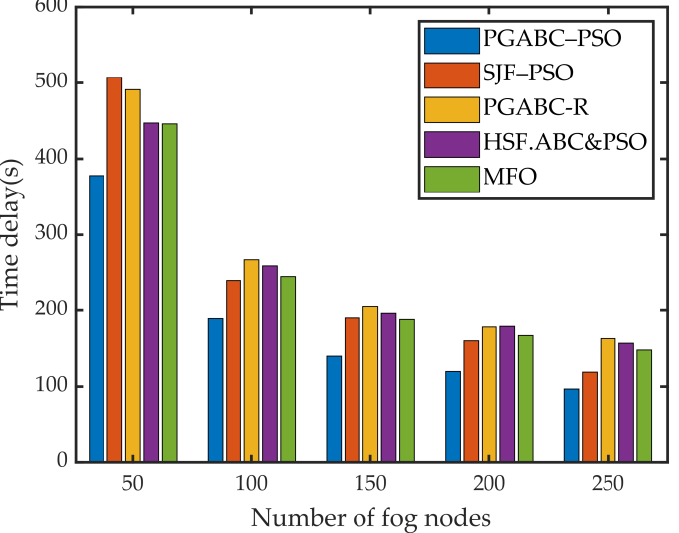
Figure 11. Total system delay of five schemes varying with fog node number.